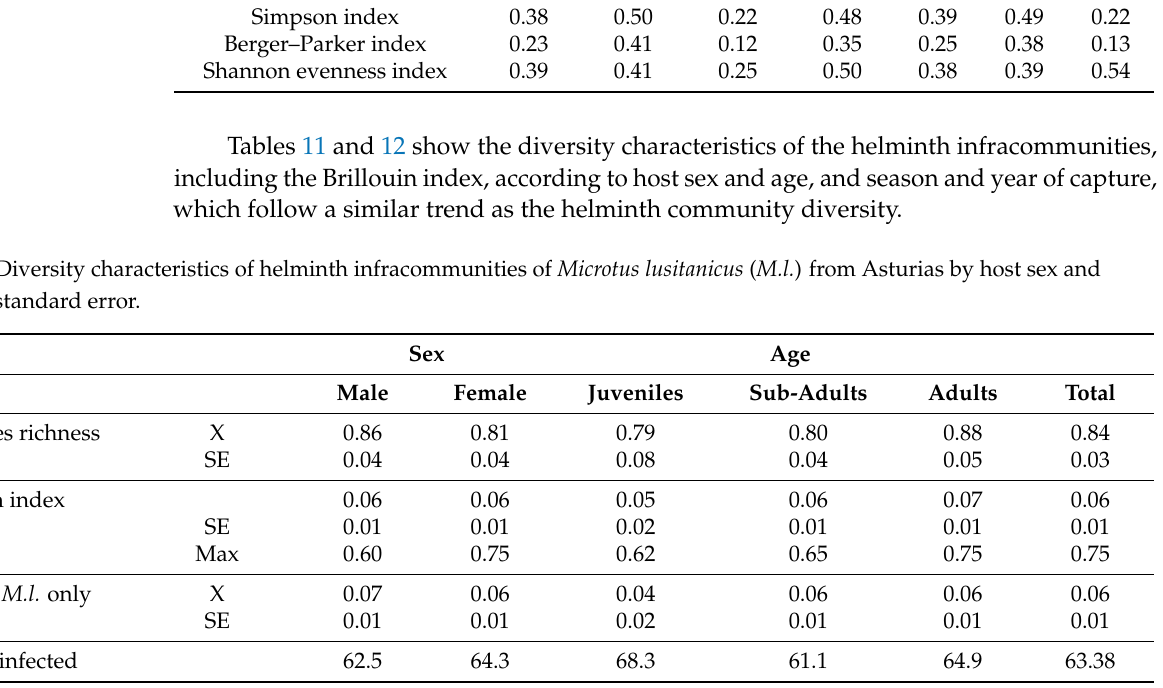
% of M.l. infected